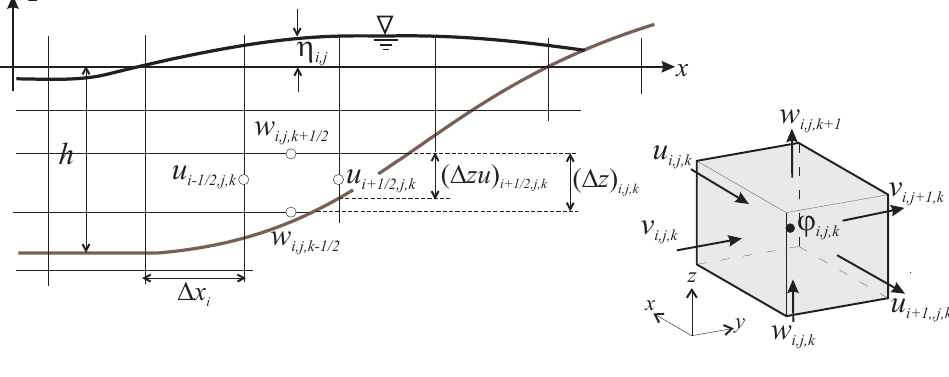
Figure 2. Computational mesh and notation used, where ϕ represents a scalar